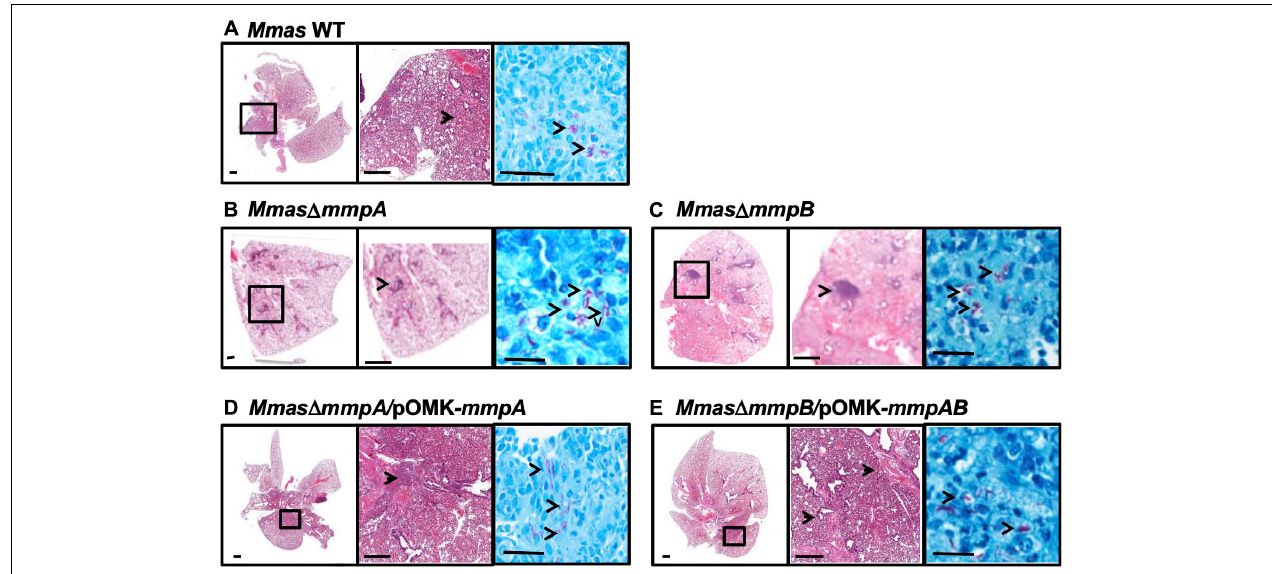
FIGURE 8 | Increased pulmonary pathology in the lungs of SCID mice infected with the mmpB knock-out. (A–E) Show representative photomicrographs of hematoxylin and eosin- and acid-fast bacilli-stained slides from the lungs of SCID mice intravenously infected with Mmas CIP108297 (A) , the mmpA mutant (B) , the mmpB mutant (C) , the mmpA mutant complemented with mmpA (D) and the mmpB mutant complemented with mmpA + mmpB (E) . As early as 15 days after infection, increased granulomatous lesions and thickening of the interstitium indicative of increased inflammation were observed in mmpB- infected mice and, to a lesser extent in mmpA- infected mice, compared to the other groups. Magnification (– 1x, – 10x and —100x